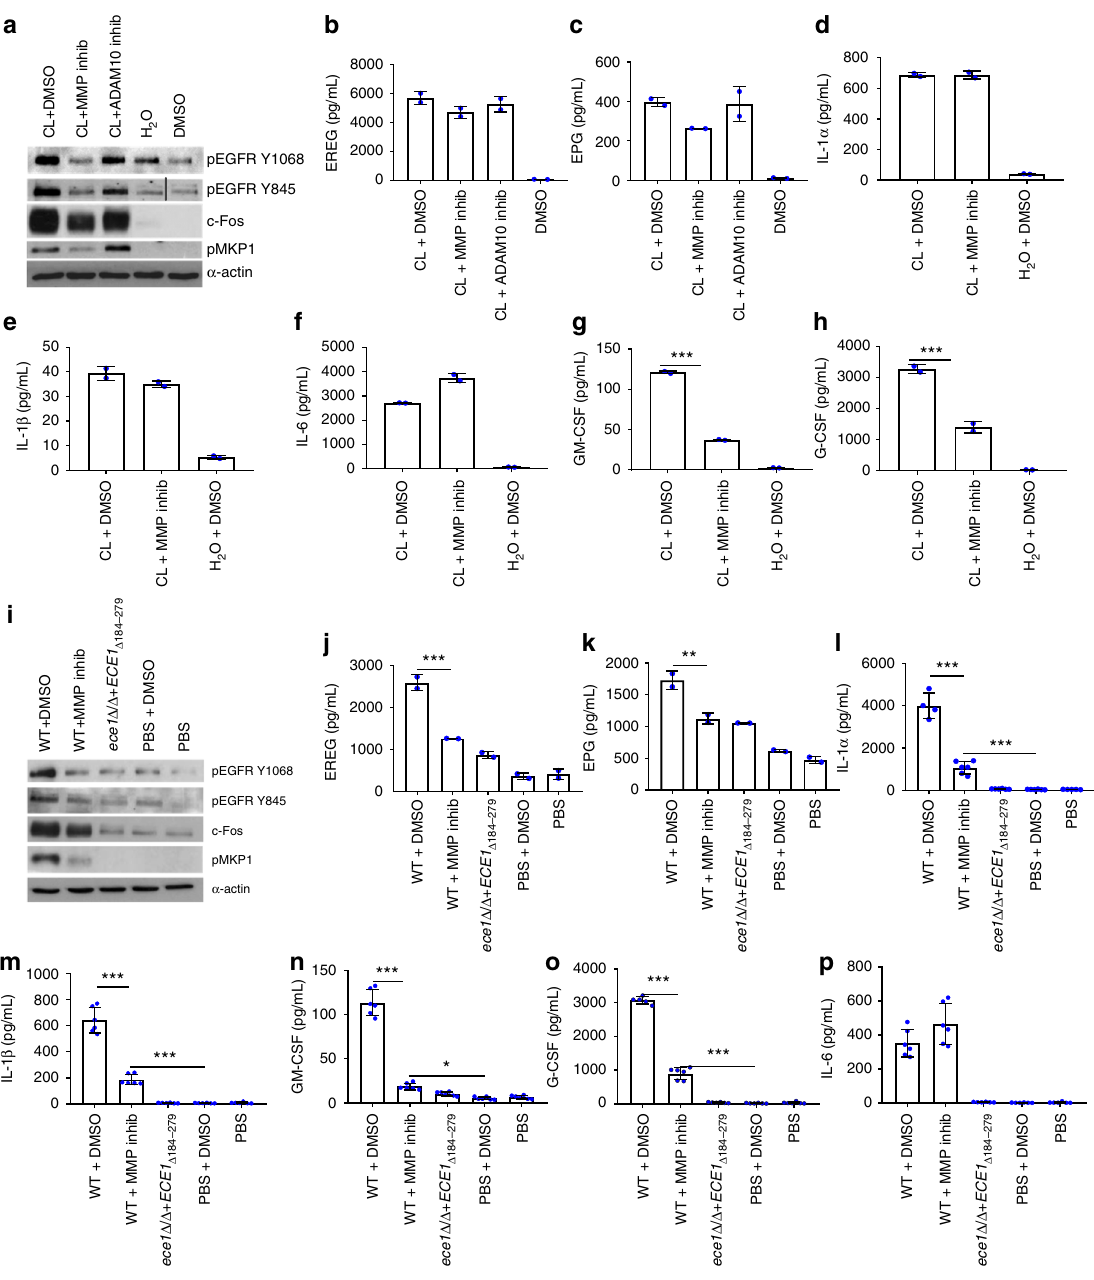
Fig. 5 MMP inhibition suppresses the candidalysin and C. albicans-induced response pathway. Pre-treatment of TR146 cells with Marimastat (MMP inhibitor, 10 µ M) but not GI-253023X (ADAM10 inhibitor, 5 µ M), signi fi cantly suppressed candidalysin-induced expression of pEGFR (Y1068 and Y845), c-Fos and pMKP1 ( a ). MMP inhibition had no suppressive effects on candidalysin-induced EREG ( b ) EPG ( c ), IL-1 α ( d ), IL-1 β ( e ) or IL-6 ( f ) but did suppress GM-CSF ( g ) and G-CSF ( h ) cytokine release. In Marimastat-inhibited, WT C. albicans-infected cells, signi fi cant suppression of all investigated proteins expression ( i ) or our panel of cytokines ( l – p ). Protein lysates were taken at 2 h post infection for western blot analysis, cytokines assessed at 24 h post infection via luminex. Solid vertical lines indicate omitted, extraneous portions of blot images. Unmatched, one-way ANOVA with Bonferroni multiple comparison ’ s test used to assess statistical signi fi cance. All images and graphs are representative of three independent experiments. One-way ANOVA with Bonferroni multiple comparison ’ s test was used to assess statistical signi fi cance. Error bars represent SD. * p < 0.05, ** p < 0.01, *** p <